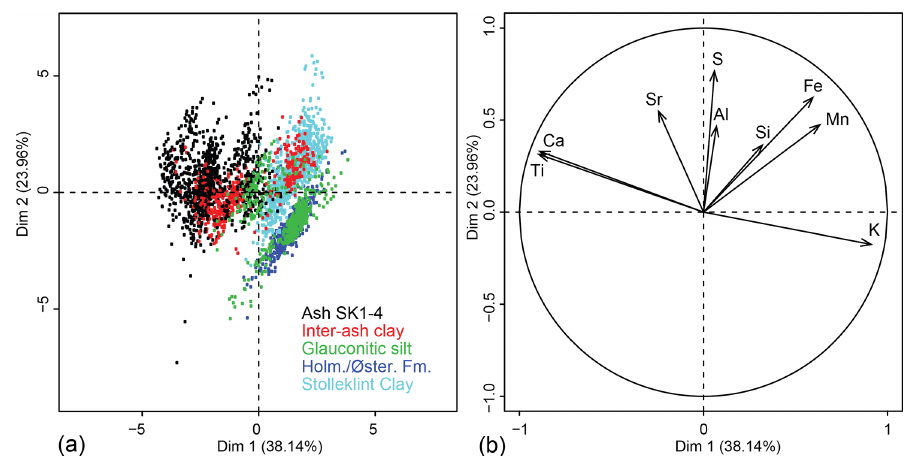
Figure 7. Biplot (a) and correlation circle (b) with dimensions 1 and 2 (denoted as Dim 1 and Dim 2) of the principal component analysis applied to XRF core scanning data from box cores 1 and 2 across the PETM onset. Dimensions 1 and 2 represent 62% of the total variability. The inter-ash clay in the biplot refers to the clay between ashes SK1 and SK2 as indicated in Fig. 5.